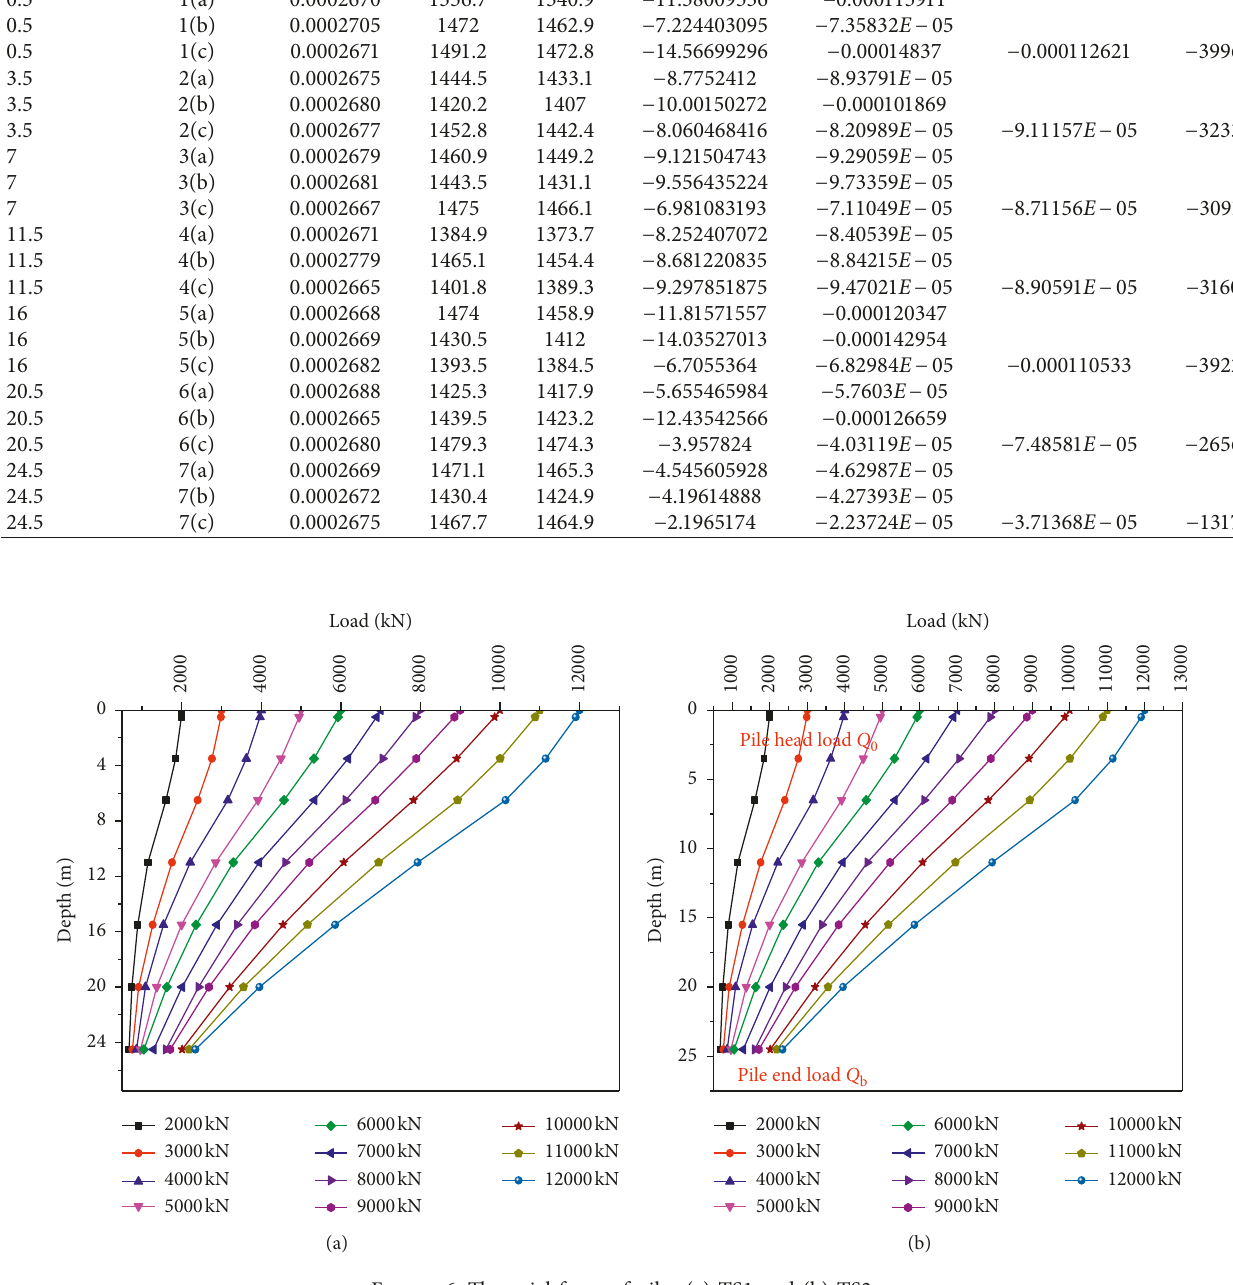
Figure 6: The axial force of piles (a) TS1 and (b) TS2.